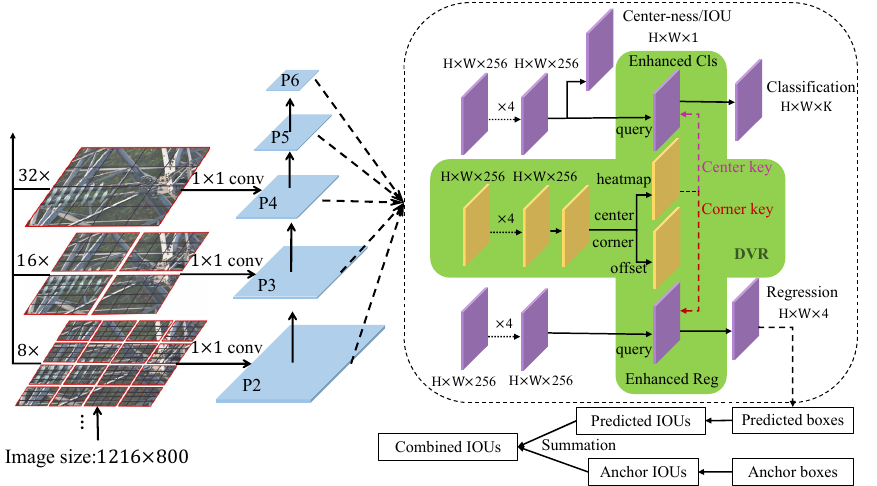
Figure 4. The framework of the heterogeneous representation auxiliary detection with contextual information. H and W are the height and width of the feature maps, respectively. K is the number of classes.